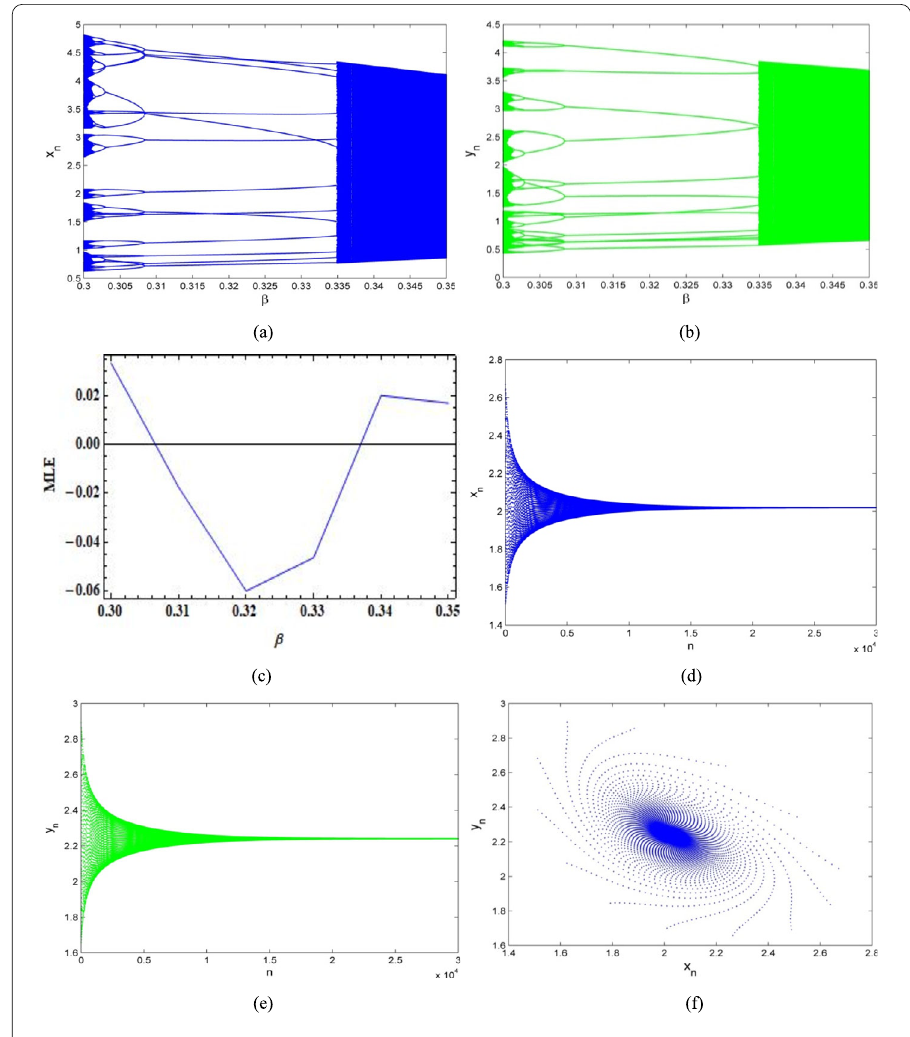
Figure 6 Local amplification of system (4) and the plot for controlled map (35) when β = 0.2112 and ρ = 0.89: ( a ) Local amplification of prey population ( b ) Local amplification of predator population ( c ) MLE for local amplification ( d ) Plot of x n ( e ) Plot of y n ( f ) Phase portrait for map (35)